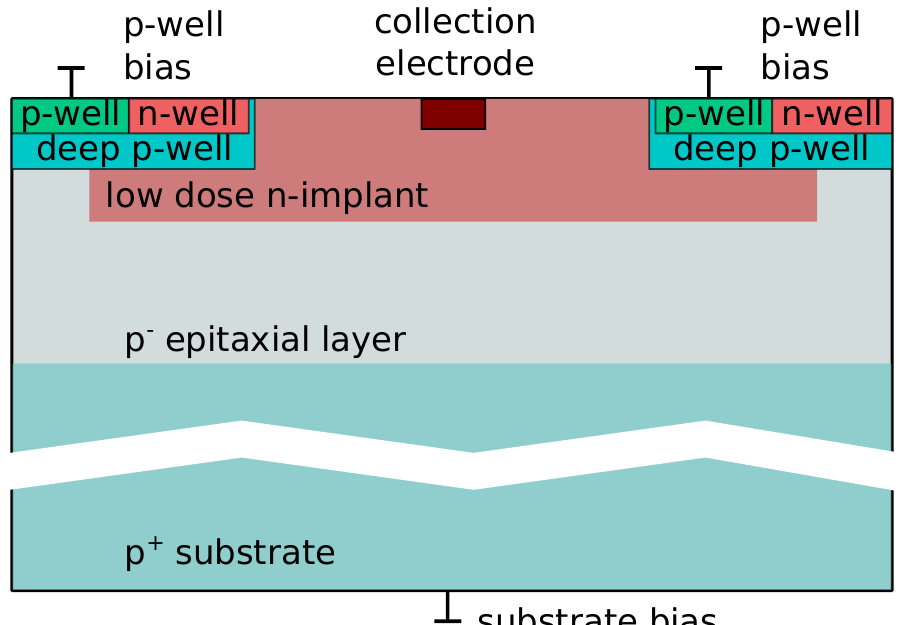
Figure 1. Cross-section of an optimized sensor design with low-dose n-implant and gap in the